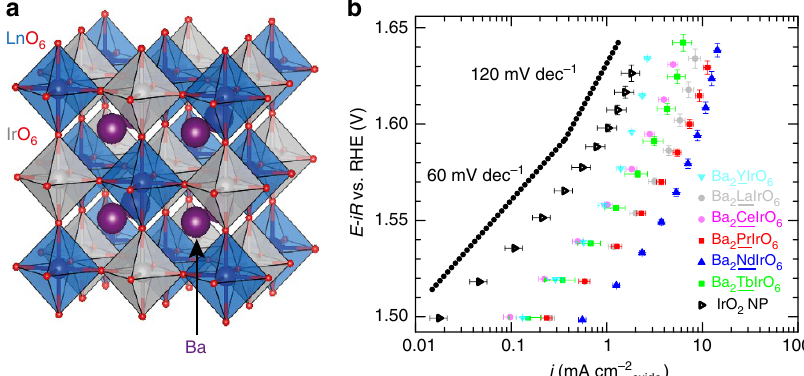
Figure 1 | Crystal structure and OER activity of the double perovskites. ( a ) Crystal structure of a generic Ba 2 MIrO 6 DP. ( b ) OER activity in 0.1M HClO 4 of Ba 2 MIrO 6 , M ¼ Y, La, Ce, Pr, Nd, Tb, compared with the benchmark activity of IrO 2 nanoparticles; the dotted lines show Tafel slopes of 60 and 120mV per decade, to guide the eye. Measurements performed under steady-state conditions. The values in the plot are the average of three independent measurements and the error bars correspond to the